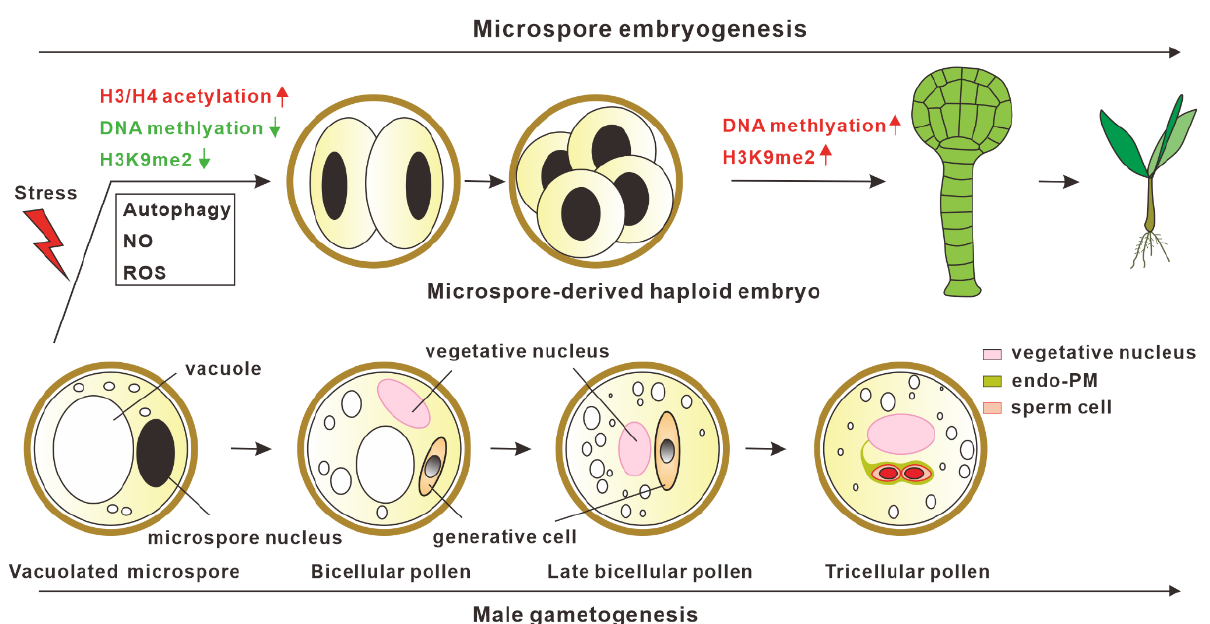
Figure 1. Model for in vitro microspore embryogenesis. After stress treatment, vacuolated microspores switch from normal male gametogenesis into the embryogenic pathway. Epigenetic modifications, autophagy, reactive oxygen species (ROS), and nitric oxide (NO) are involved in promoting the initiation of microspore